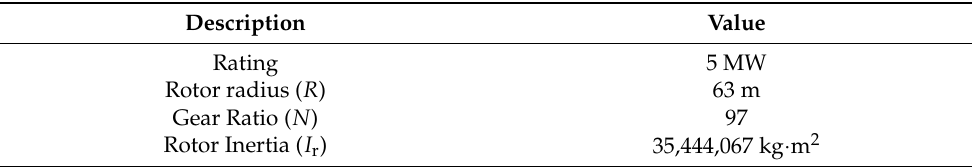
Table 1. Main parameters of NREL 5MW turbine used for algorithm